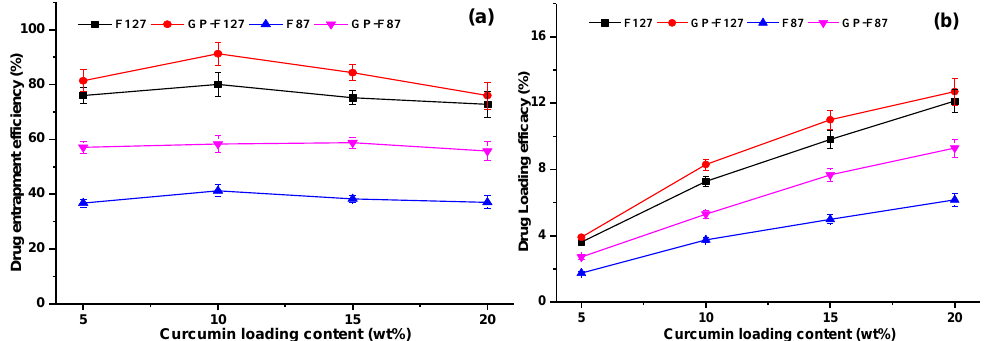
Figure 5. Entrapment efficiencies ( a ) and drug-loading efficacy ( b ) of pluronics and its grafted forms (GP-F127 and GP-F87). (GP-F127 and GP-F87). Table 2. Zeta potential of pluronic and pluronic-grafted gelatin copolymers.